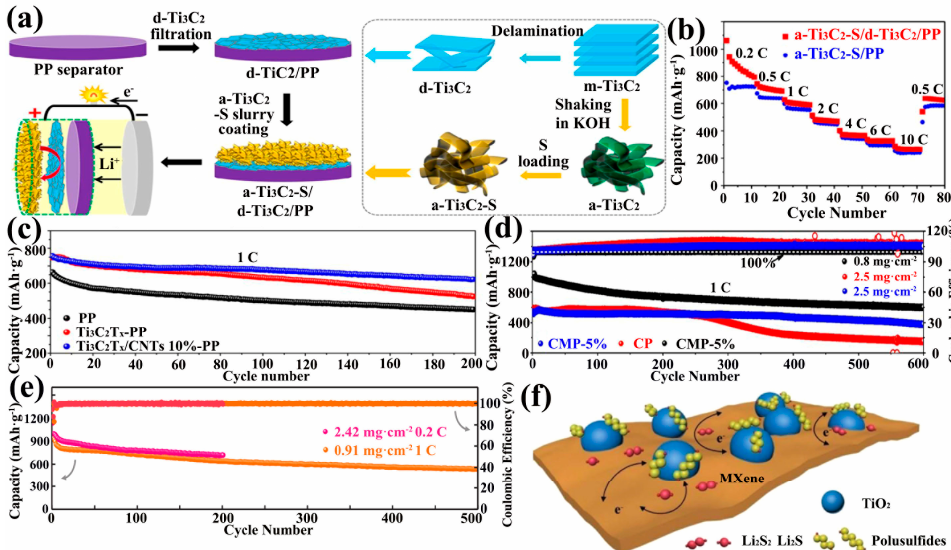
Figure 10. Preparation process of a Ti 3 C 2 -S/d-Ti 3 C 2 /PP electrode for LSBs ( a ) and its rate performance ( b ) [114]. Copyright 2018, American Chemical Society. Long-cycle performance of LSBs of